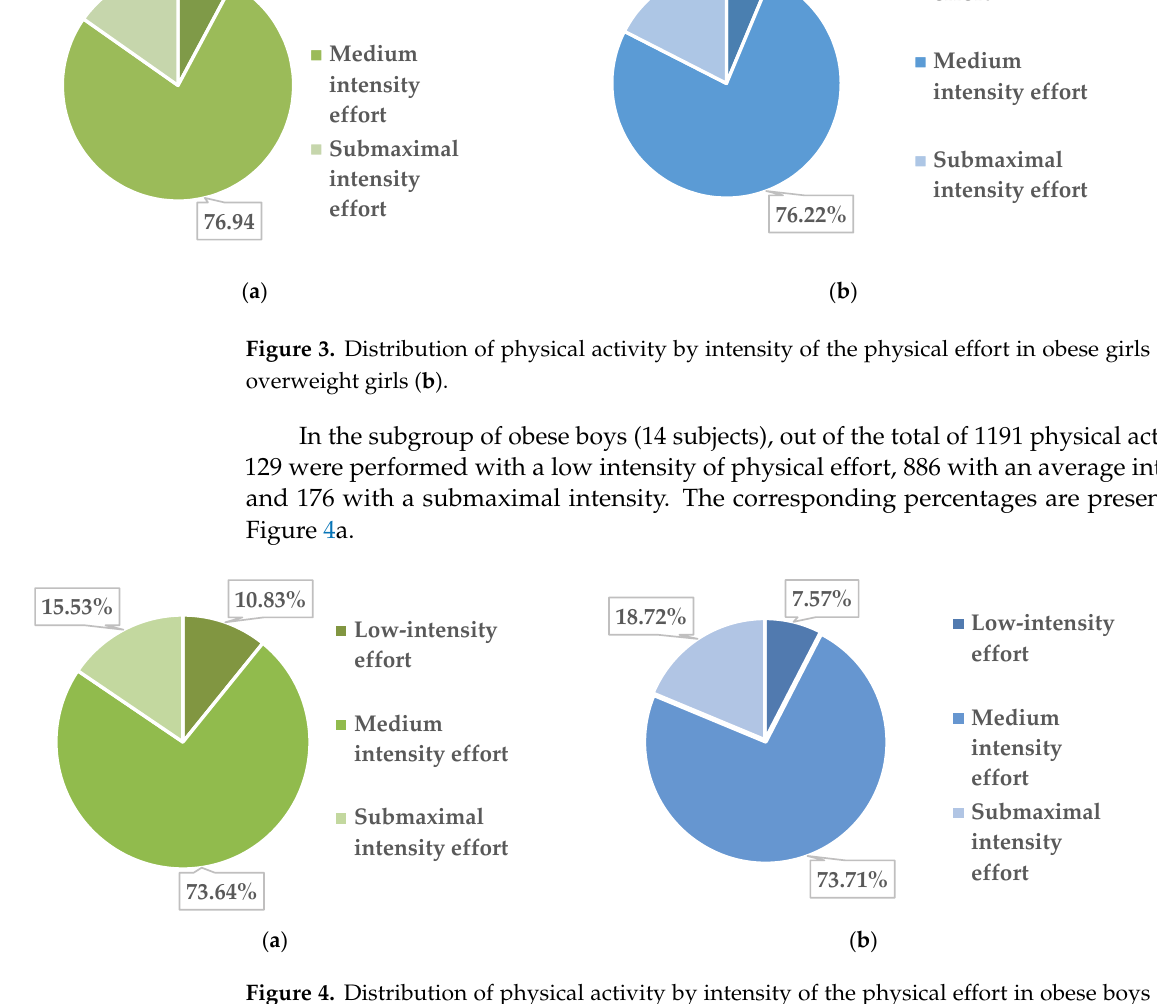
10 of 21 Figure 2. Distribution of total weekly time spent on physical activity. 3.4. Averages/Subgroup Effort Intensity of the Physical Activities To determine the average of the physical activities/subject according to the intensity of the physical effort, we cumulated the frequency of the physical activities performed (percentages) by each subject, and subsequently, divided the obtained result by the total number of subjects corresponding to each of the 4 subgroups. The collected data highlight the fact that during the 26 weeks of activity, in the group of obese girls (13 girls), out of the total of 1253 physical activities performed, 98 were per- formed with a low intensity of physical effort, 964 were performed with an average inten-